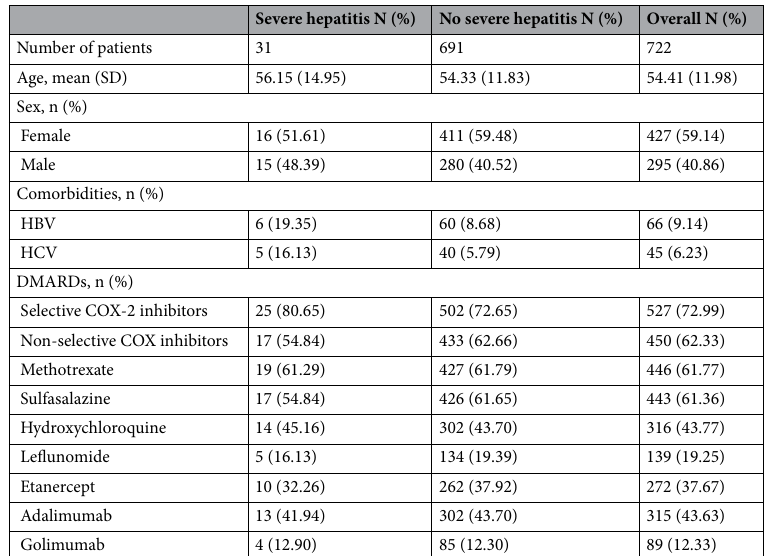
Severe hepatitis N (%) No severe hepatitis N (%) Overall N